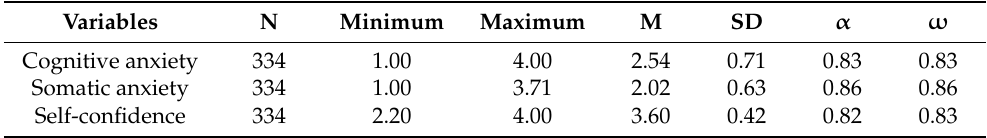
Table 2. Descriptive statistics and reliability analysis.